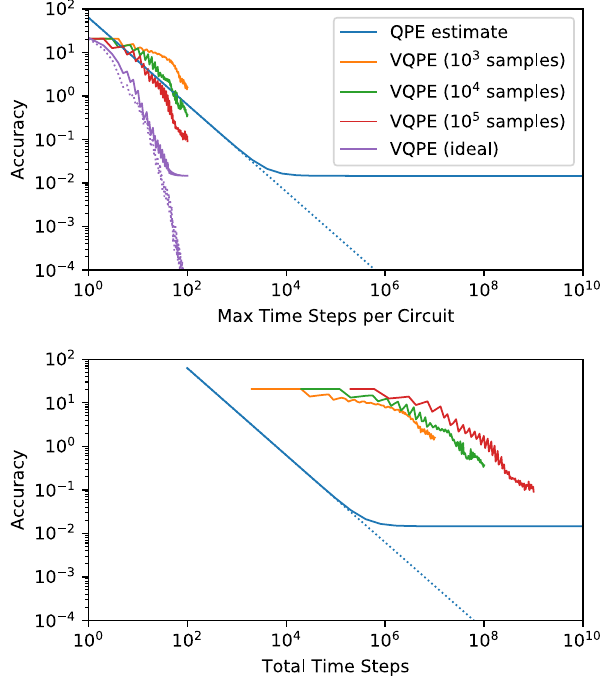
FIG. 6. Accuracy comparison between VQPE and QPE for the ground-state energy of the ten-qubit transverse field Ising model with first-order Trotterization and (cid:10) t = 0.05. We use SVD cut- offs of 1, 0.6, and 0.2 respectively corresponding to 10 3 , 10 4 , and 10 5 samples and 10 − 5 for the ideal case. Dotted lines show QPE and idealized VQPE results without Trotter errors. The reference state, | (cid:2) (cid:3) = | φ (cid:3) ⊗ 10 , is a product state the maximizes overlap with the exact ground state, |(cid:4) (cid:4) 0 | (cid:2) (cid:3)| 2 ≈ 0.014 for | φ (cid:3) ≈ 0.979 | 0 (cid:3) + 0.205 | 1 (cid:3) .